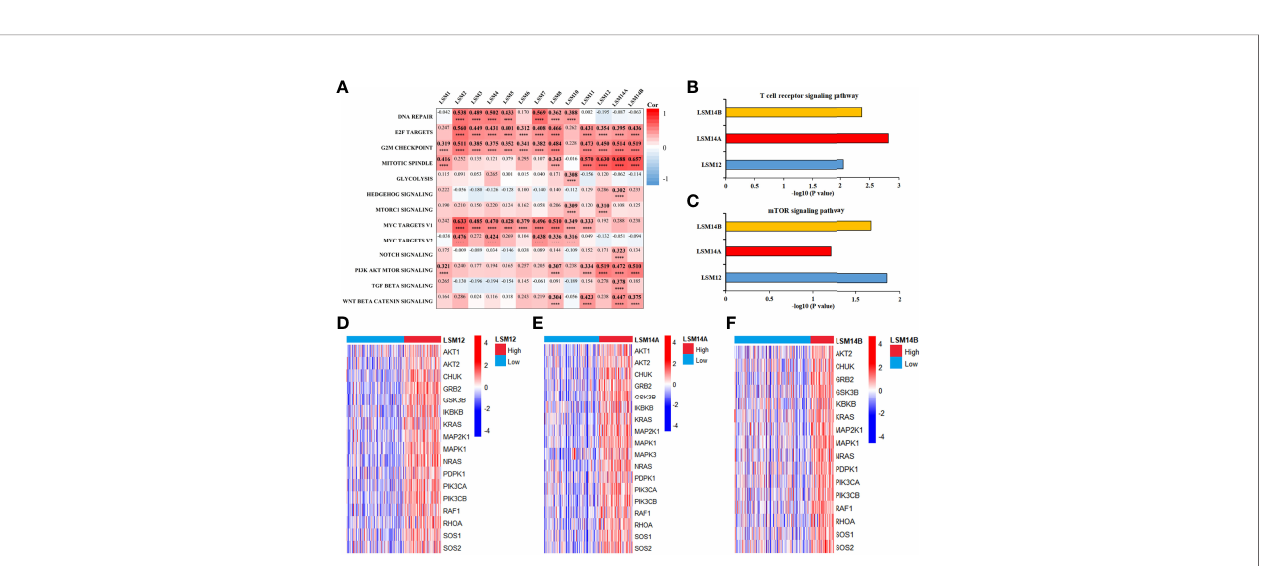
FIGURE 6 | Functional enrichment analysis for LSM family members in HCC. (A) Heat map to show the correlation between LSM family and critical biological pathway. (B) KEGG analysis demonstrated that LSM12, LSM14A, and LSM14B may play important role in T cell receptor signaling pathway in HCC. (C) KEGG analysis also identi fi ed the underlying interactions between the mTOR signaling pathway and LSM12, LSM14A, and LSM14B. (D – F) Heat maps to show the overlapped co-expressed genes involved in T-cell receptor signaling pathway and mTOR signaling pathway for LSM12, LSM14A, and LSM14B, respectively. LSM, Smith-like (LSM) family members; KEGG, Kyoto Encyclopedia of Genes and Genomes analysis; HCC, hepatocellular carcinoma. ****P-value